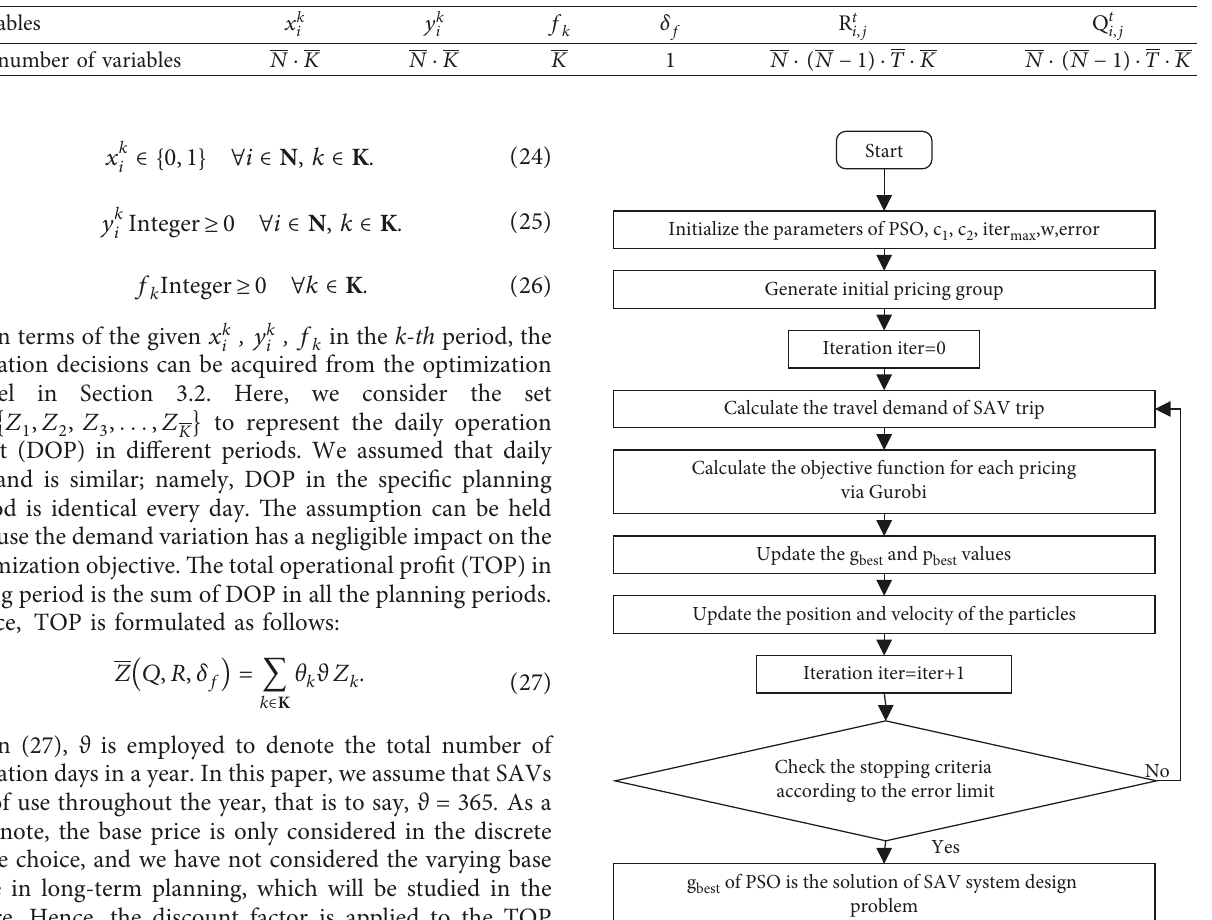
Table 3: The statistical number of variables in the proposed model.